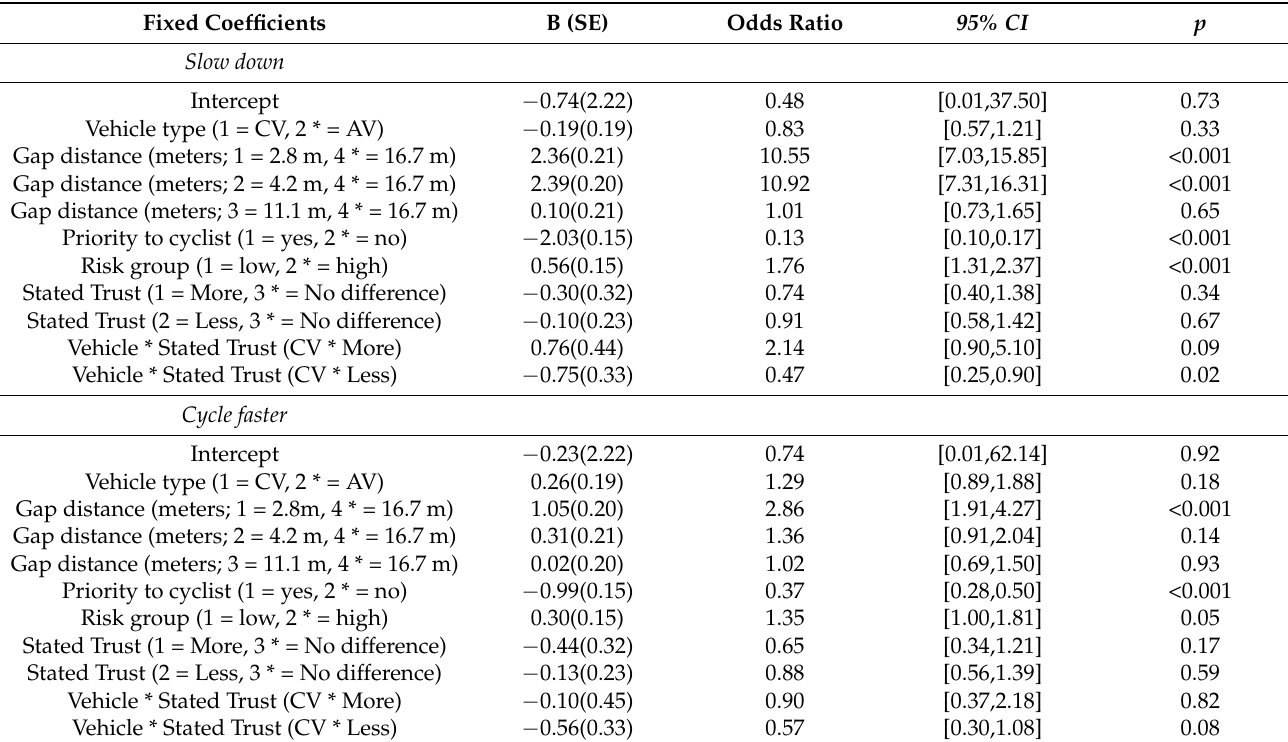
Table 2. Results of the Crossing Intention Multinomial Logistic Mixed Regression (MLMR) Model for both sessions combined. Fixed